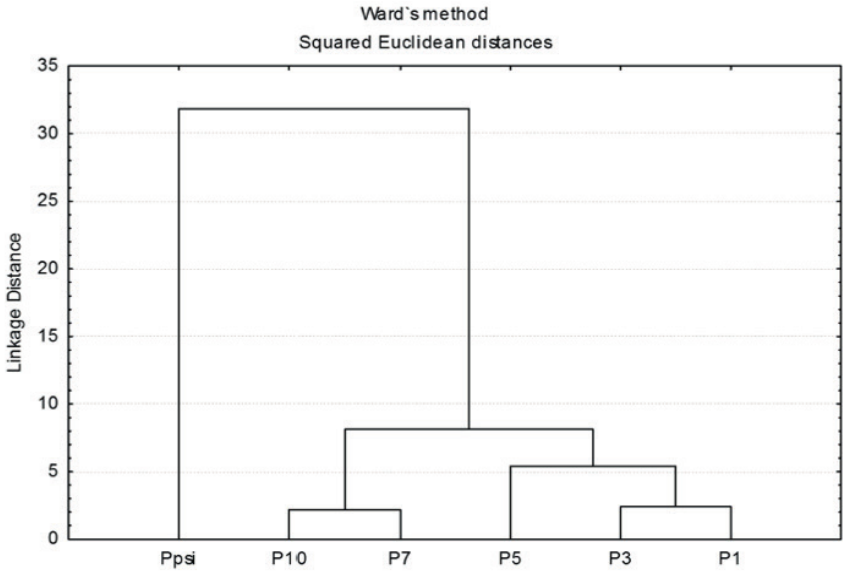
Figure 11 - Dendrogram based on sedimentary characteristic separating those under the influence of fish cages and other stations in the